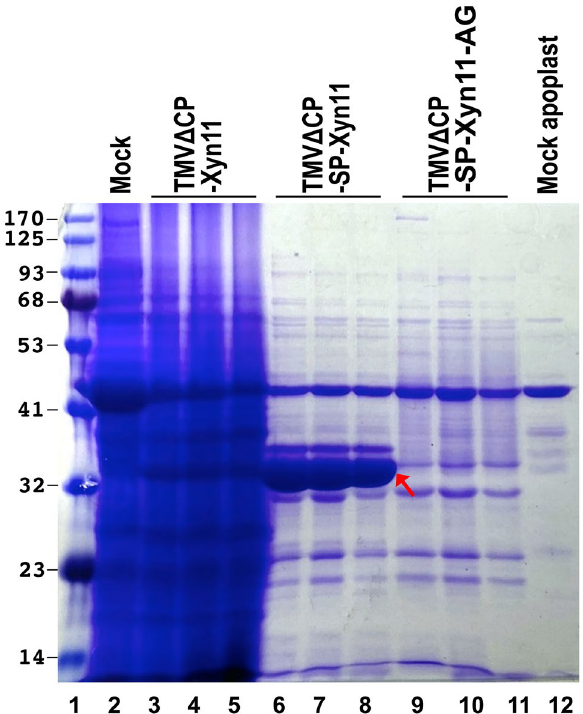
Figure 2. Electrophoretic analysis of protein extracts from N. benthamiana leaves infiltrated with different viral vectors. Leaves were harvested at 7 dpi and protein extracts were prepared from whole tissues or after recovery of apoplastic liquid. Proteins were separated by SDS-PAGE, and the gel was stained with Coomassie brilliant blue. Lane 1, marker proteins (BlueStar prestained protein marker, Nippon Genetics) with size in kDa on the left; lanes 2 to 5, total proteins from a mock-inoculated plant (lane 2) or three independent plants inoculated with TMV-Xyn11 (lane 3 to 5); lanes 6 to 12, proteins from apoplastic liquid recovered from three